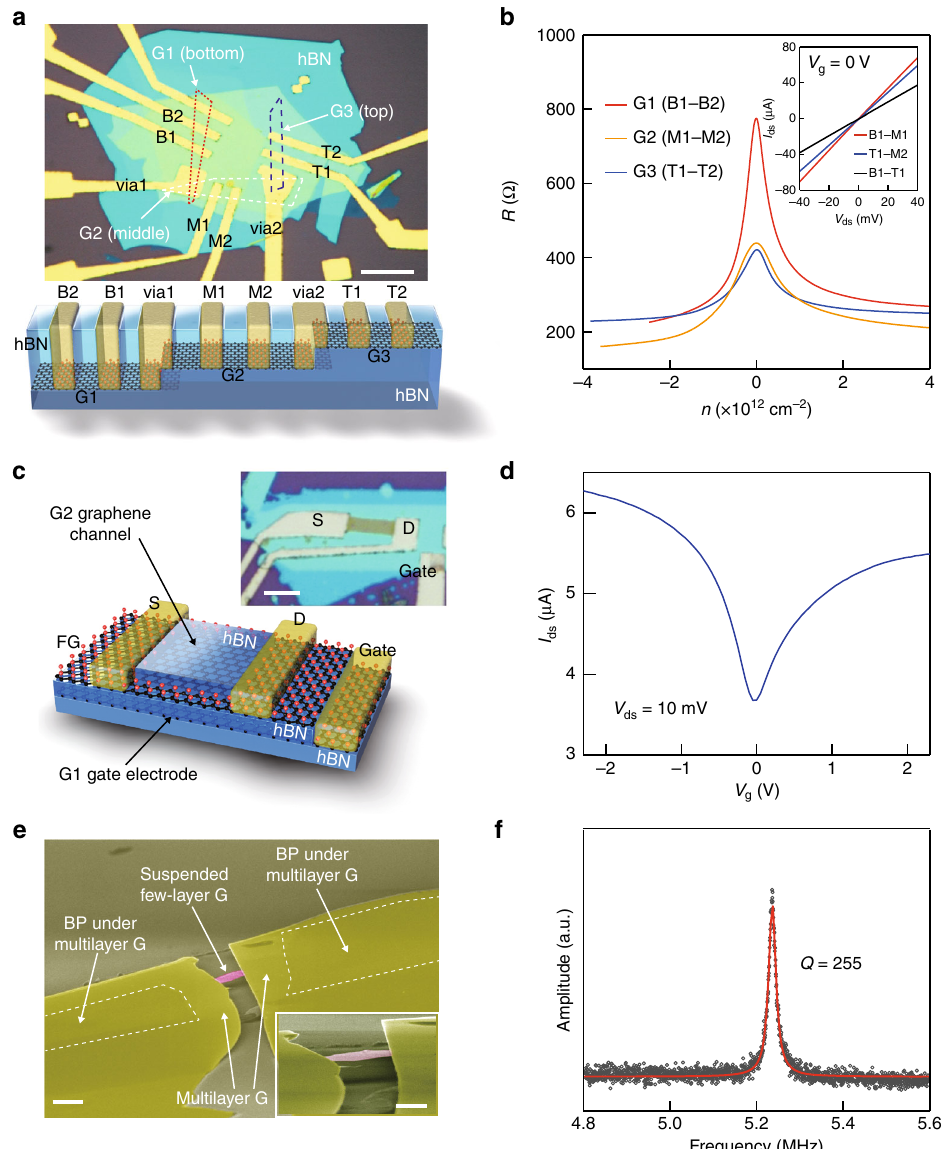
Fig. 4 Fabrication of 3D integrated devices from 2D materials and suspended graphene mechanical resonators with a dry and one-step etching process. a Optical microscopic image and schematic illustration of the multi-stacked graphene devices connected with via contacts (the scale bar is 10 μ m). Source and drain contacts were denoted as B1 and B2 for bottom graphene device (G1), M1 and M2 for middle graphene device (G2), and T1 and T2 for top graphene device (G3). All the graphene devices are connected with two via contacts (via1 and via2). b Plots of resistance vs. carrier density of multi- stacked three graphene devices in a . The inset shows I ds − V ds curves obtained from two graphene devices connected with via1 or via2. Linear curves and small resistance indicate that these three graphene devices embedded in hBN are electrically connected with low resistance via contacts. c Optical microscopic image and schematic illustration of the hBN-encapsulated graphene device with graphene backgate (the scale bar is 5 μ m). d I ds − V g curve of the graphene device (G2) in c . Gate voltage was applied with bottom graphene (G1). e False-color scanning electron micrograph of the suspended graphene membrane (the scale bar is 2 μ m). The inset is a magni fi ed image of the suspended membrane (the scale bar is 1 μ m). f Plot of normalized amplitude vs. frequency of the few-layer graphene resonator. Black circles and red solid line are the optomechanical response and Lorentzian fi t,